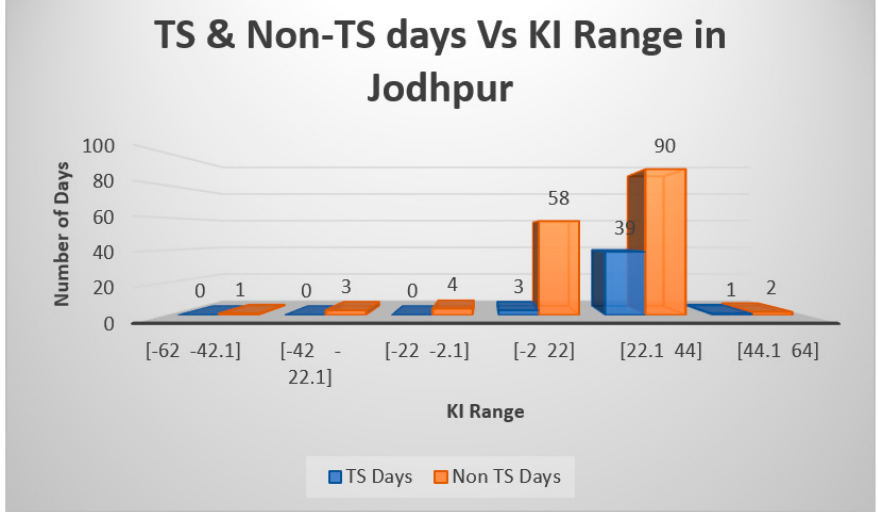
Figure 5. The distribution of thunderstorm and nonthunderstorm days in the given KI range over Jodhpur.